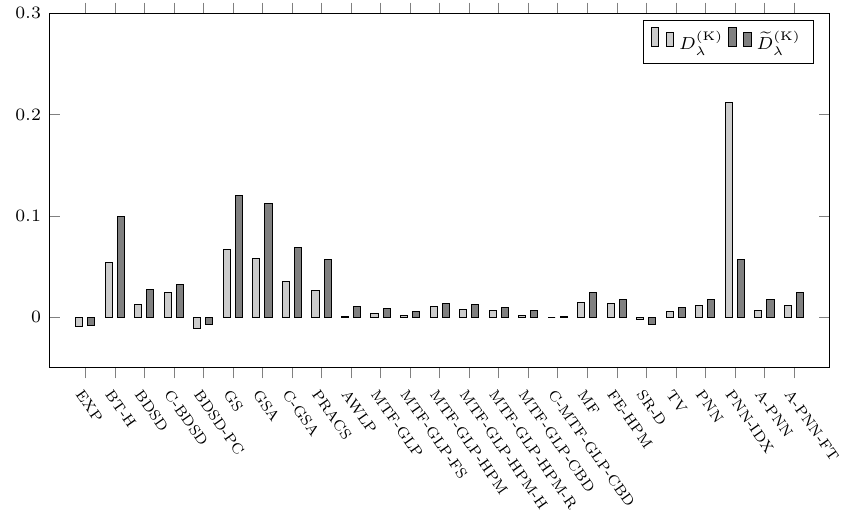
Figure 2. Misregistration impact on D ( K ) due to data misragistration.